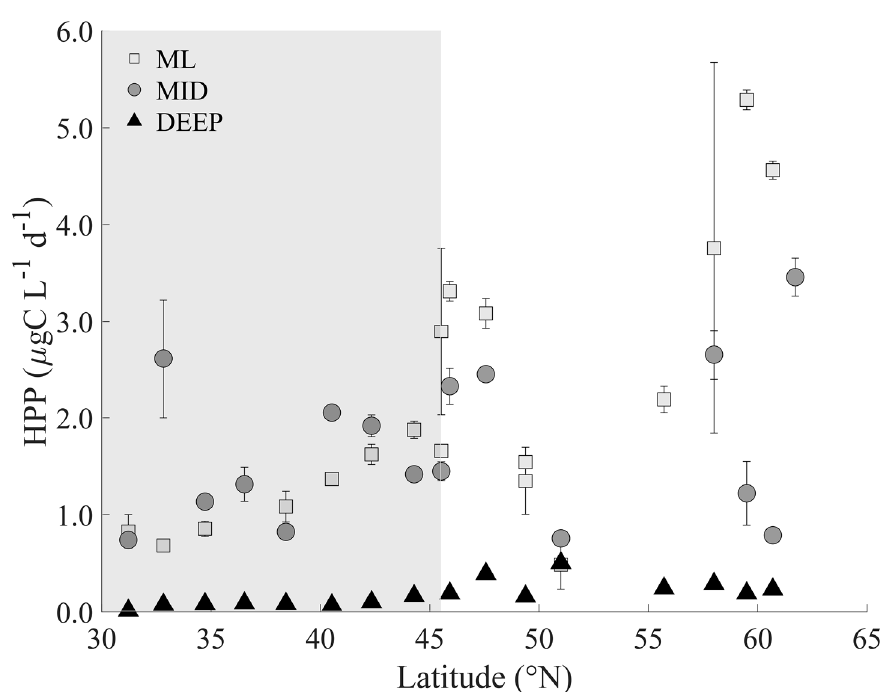
Figure 3. Heterotrophic prokaryote production (HPP) measured in the Northeast Atlantic during the summer STRATIPHYT cruise. Rates were obtained from 3 separate depths: the mixed layer (ML; 15 m), below the mixed layer (MID; 25–85 m), which included the deep ‐ chlorophyll maximum where present (DCM; 47–85 m; defined by the presence of a subsurface peak in the vertical profile of Chl a autofluorescence), and deep (DEEP; 100–225 m). Error bars represent standard error ( n = 3). The gray shaded area represented the latitudinal range of stations with a DCM present.